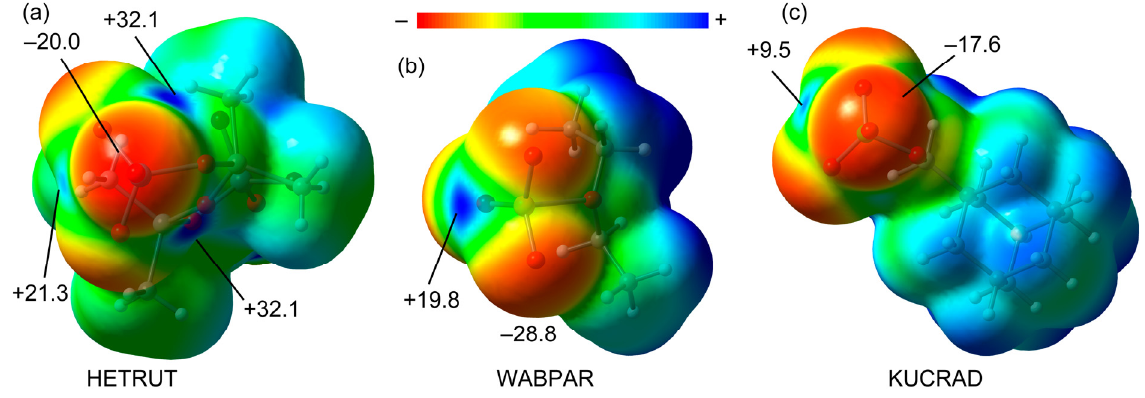
Figure 3. MEP surfaces of HETRUT ( a ), WABPAR ( b ) and KUCRAD ( c ). The energies at selected points of the surfaces are given in kcal/mol.